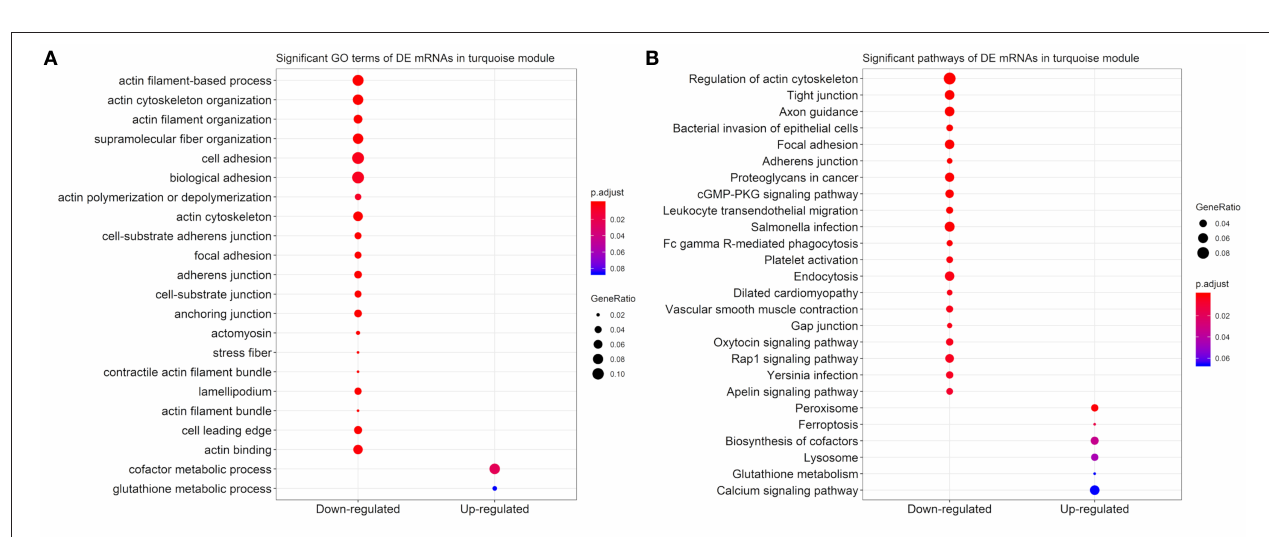
FIGURE 7 | Scatter plots for the significant (A) Gene Ontology (GO) terms and (B) Kyoto Encyclopedia of Genes and Genomes (KEGG) pathways in the down-regulated and up-regulated categories of 2,579 differentially expressed (DE) mRNAs in turquoise module. Only the top 20 significant GO terms and KEGG pathways were